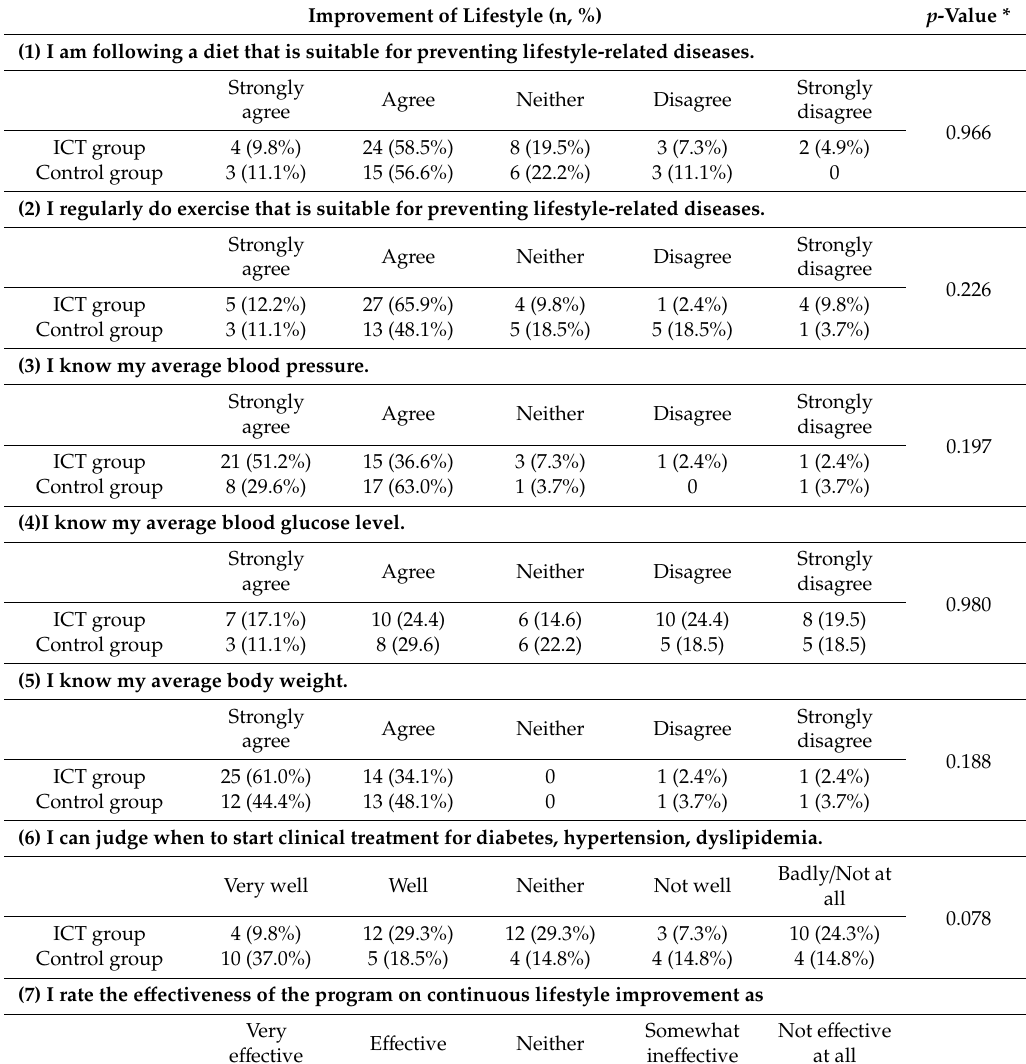
Table 5. Comparing insight into health behavior between the ICT and control groups. Improvement of Lifestyle (n, %) p -Value